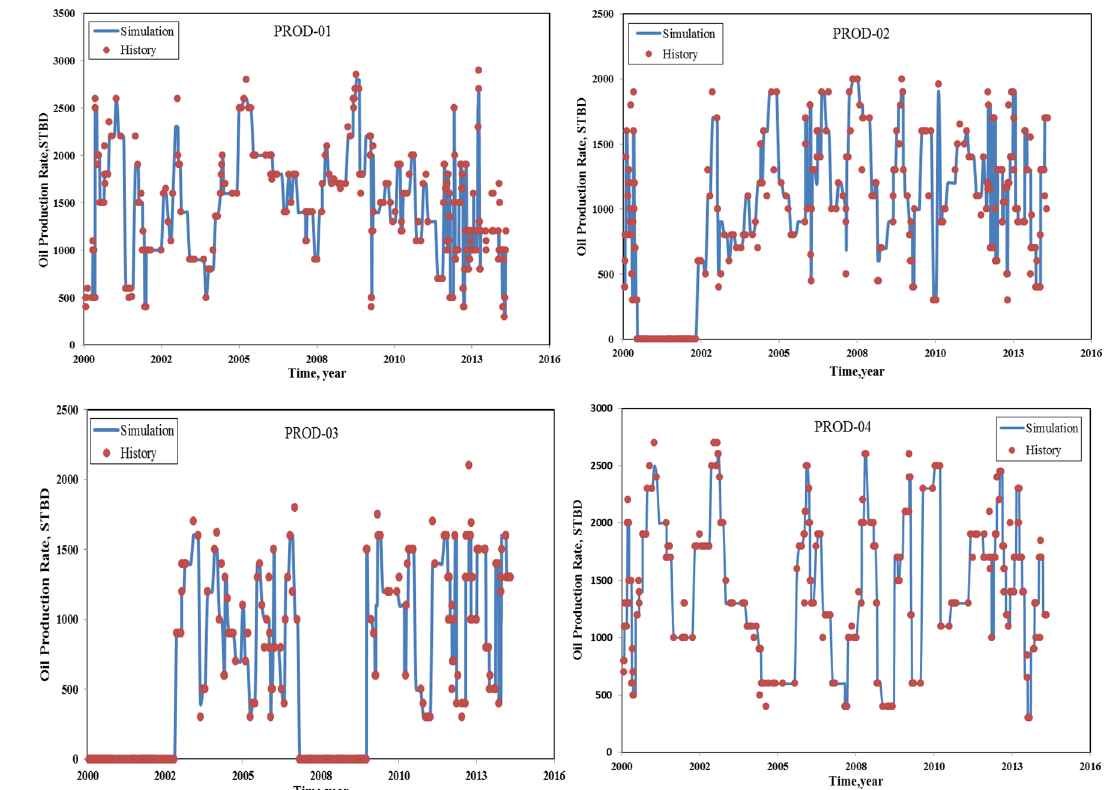
Fig. 6 History matching results of oil production rate of different wells Fig. 7 History matching results of field